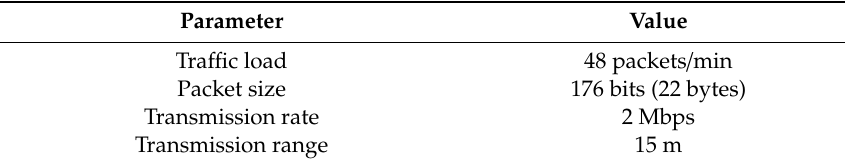
Table 5. Workload parameters.